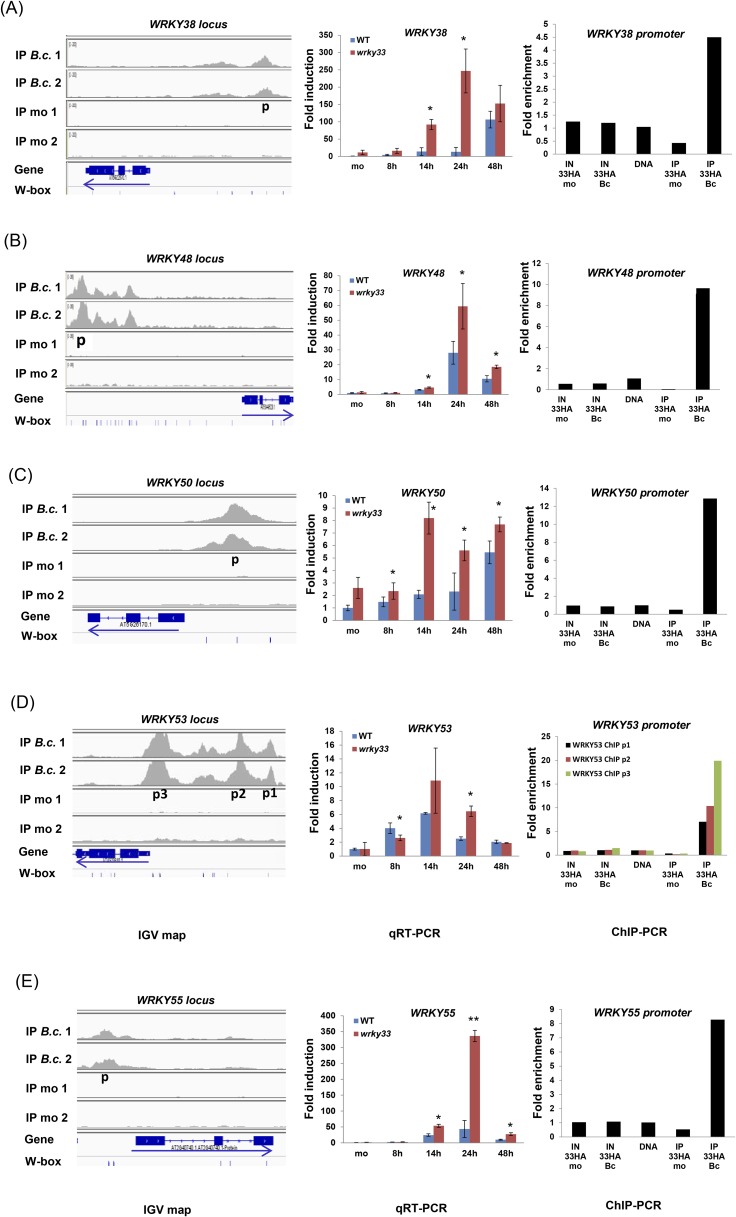
Validation of WRKY33 directly regulated WRKY genes.Shown for each of the WRKY genes 38 (A), 48 (B), 50 (C), 53(D), and 55 (E), are; (i) the ChIP-seq data, visualized in the IGV browser, revealing strong infection-dependent WRKY33 enrichment at the corresponding promoter, (ii) qRT-PCR analysis of B. cinerea 2100-induced expression of the respective WRKY gene in WT and wrky33 at indicated time points post spore inoculation, and (iii) ChIP-qPCR confirmation of WRKY33 binding to the respective WRKY promoter. Amplicons used are indicated in the IGV images (p, p1, p2, p3). For detailed descriptions on how qRT-PCR and ChIP-qPCR were performed see legend to Figure 3.